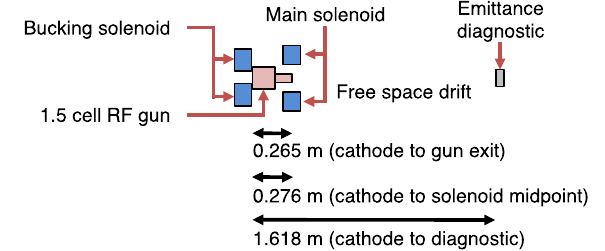
FIG. 24. Schematic of PITZ injector used in the